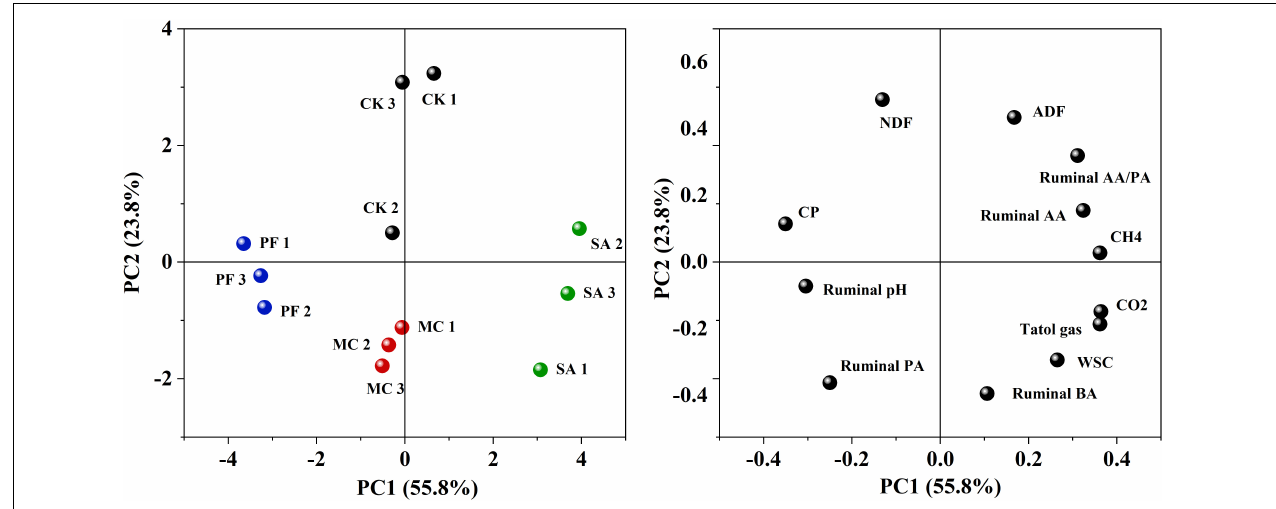
FIGURE 6 | PCA biplots of separation of treatments and distribution of all variables after 75 days of ensiling. CK, without additives; MC, 5% mint; SA, 5% clove; PF, 5% purple perilla. CP, crude protein; NDF, neutral detergent fiber; ADF, acid detergent fiber; WSC, water-soluble carbohydrate; AA, acetic acid; PA, propionic acid; BA, butyric